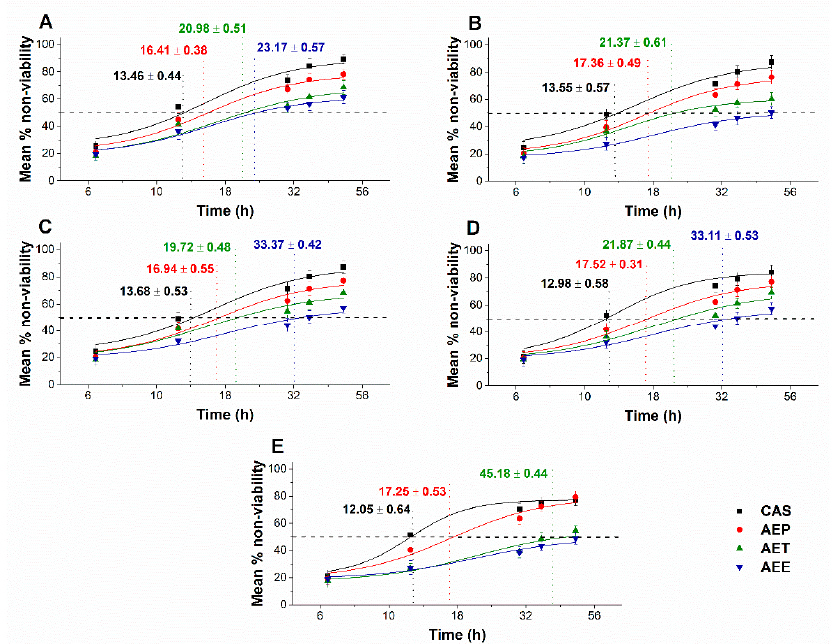
Figure 14. Mean percentage non-viability of AEP, AET, and AEE at their MEC 10 concentrations on the metabolic activities of the planktonic S. pombe ( A ), C. albicans ( B ), C. tropicalis ( C ), C. dubliniensis ( D ) and C. krusei ( E ) compared to their respective 0 h samples prior and caspofungin (CAS) standard antimicrobial controls after 6, 12, 30, 36 and 48 h of treatment (mean ± SD, n = 6 independent experiments each with three technical replicates).